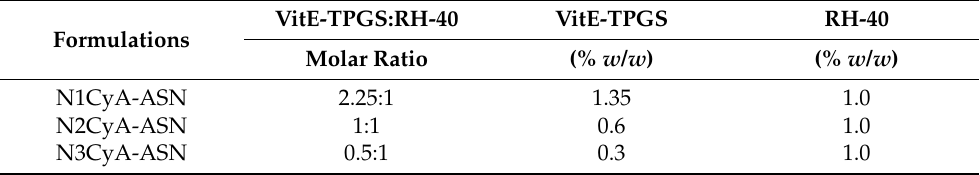
Table 1. Composition of Cyclosporine-A loaded nanomicellar formulations (NxCyA-ASN).